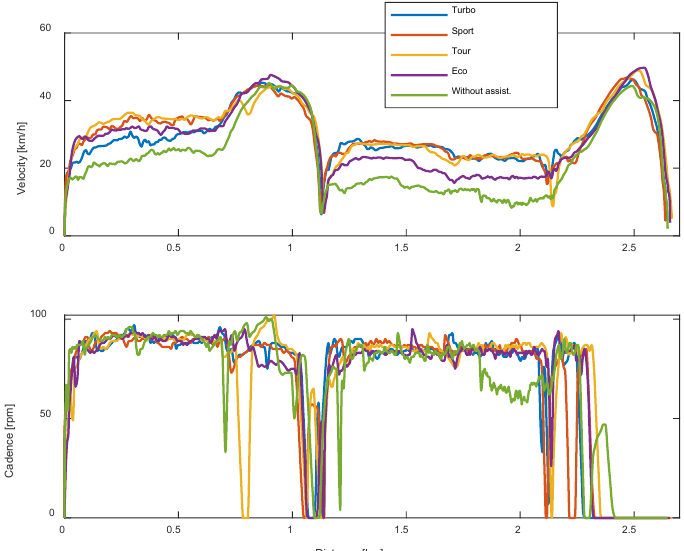
Figure 5. Examples of recorded cadence and speed signals in various assist modes.